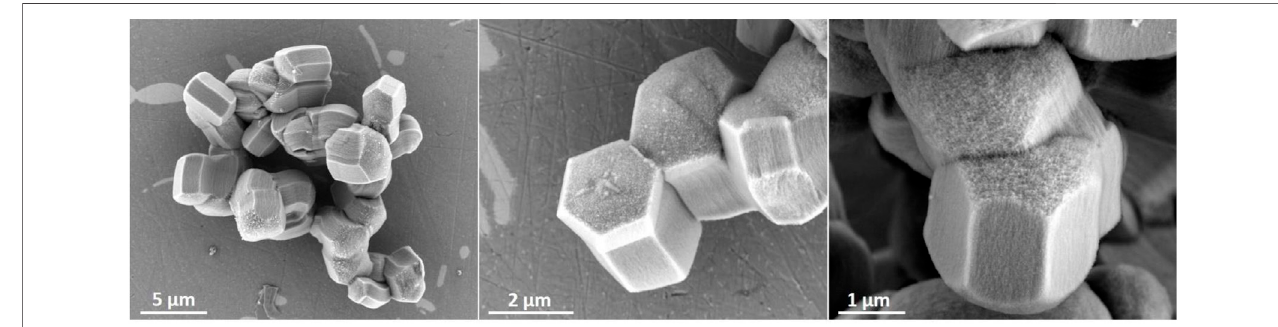
FIGURE8| Zeotile-4 synthesizedusing the procedure discussed inPulinthanathu Sreeet al. (2012) and Pulinthanathu Sreeet al. (2017) withthe addition ofLiClto Pluronic P123.